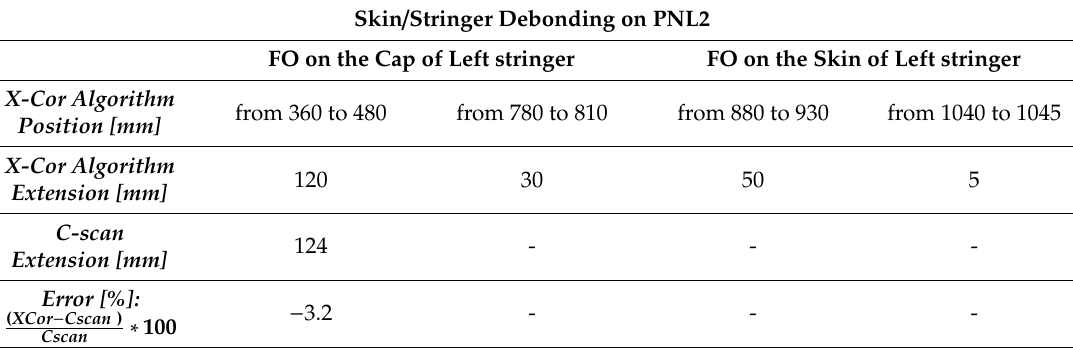
Table 2. Damage position estimation for